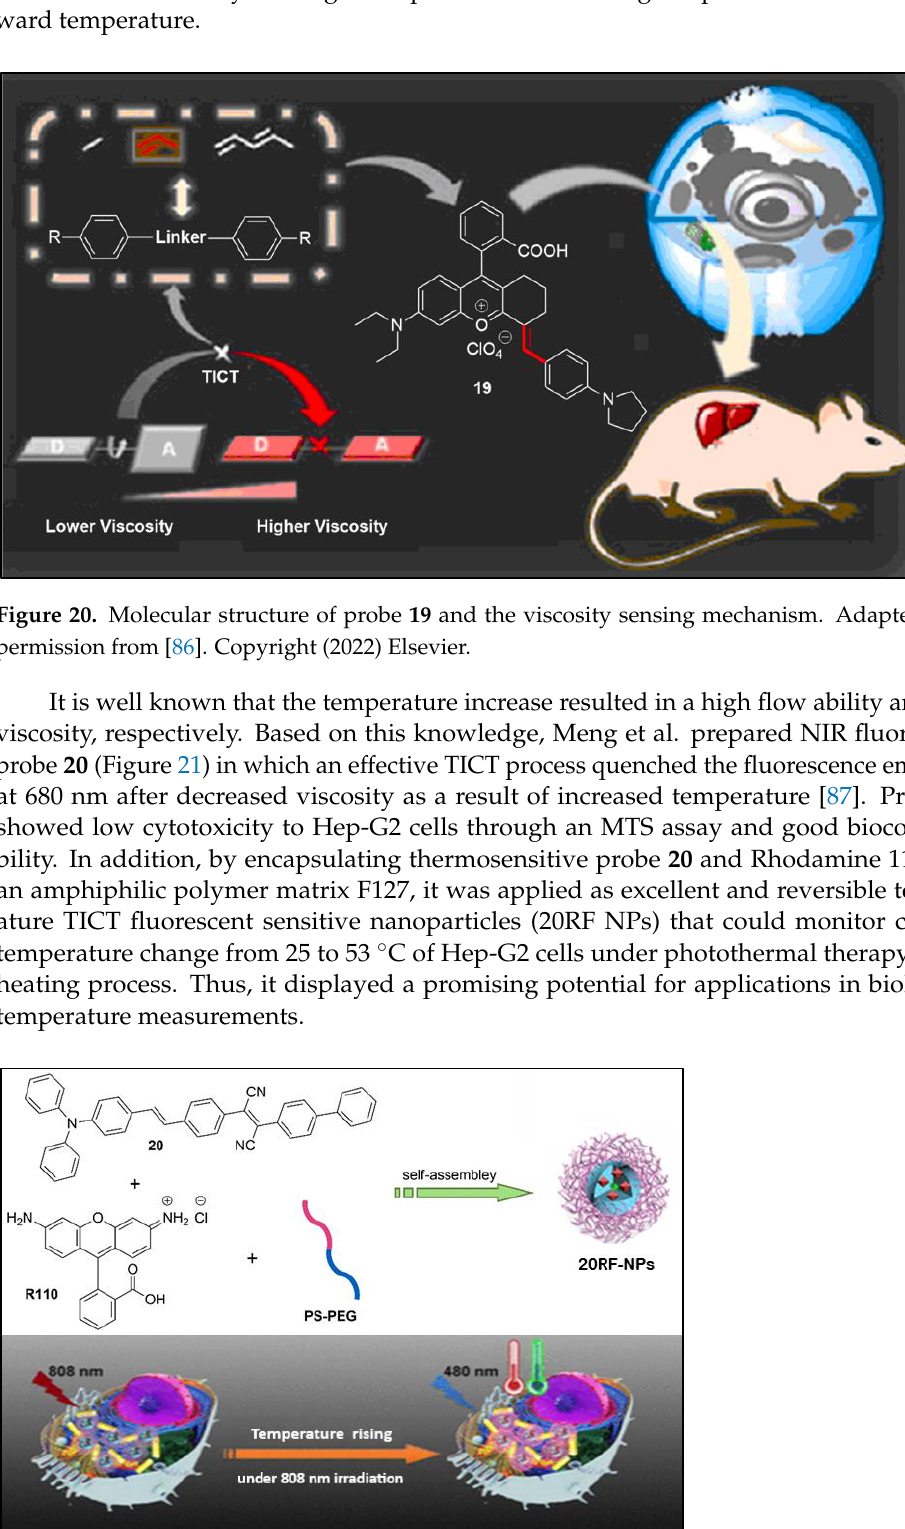
15 of 51 Figure 19. Transformation of probe 18 in monitoring viscosity fluctuation in idiopathic pulmonary fibrosis. In vivo imaging of bleomycin-induced IPF mice model in 14 days, λ EX = 640 nm, λ F